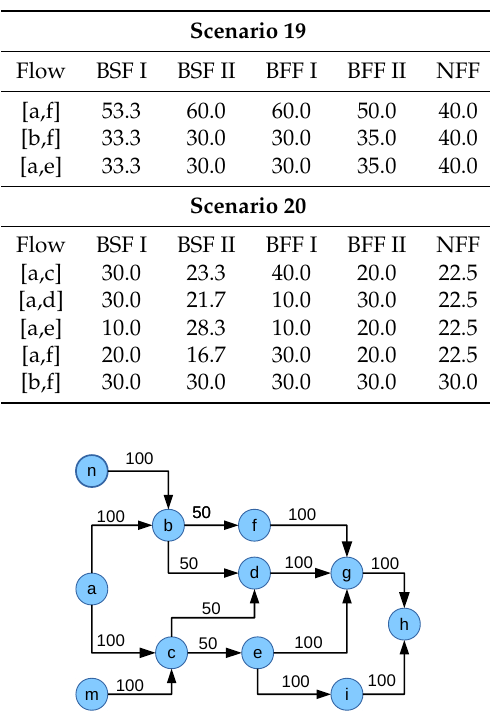
Table 6. Flow set and LP results for the flows’ end-to-end throughput for scenarios 19 and 20 described in Figure 17. All values in Mbps.